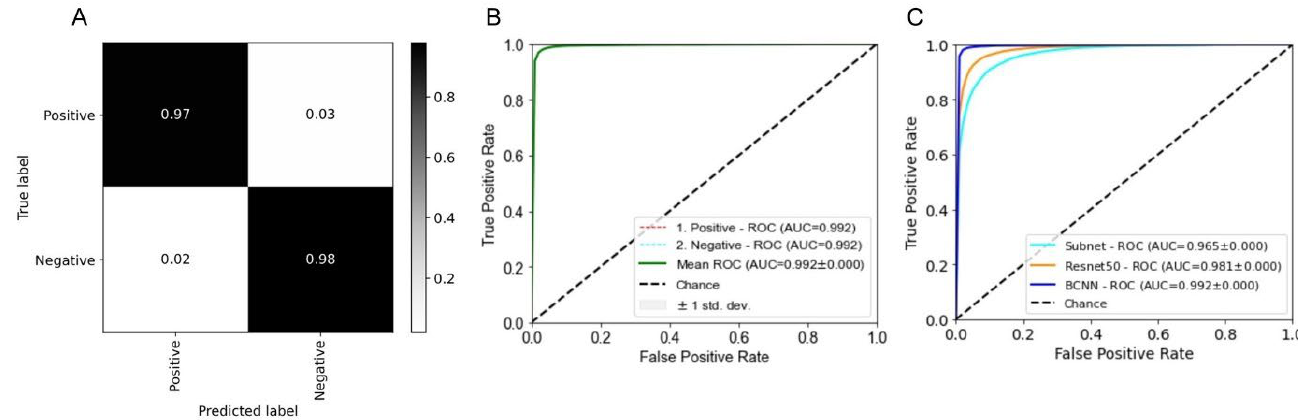
Table 1. Performance evaluation of different deep learning models.